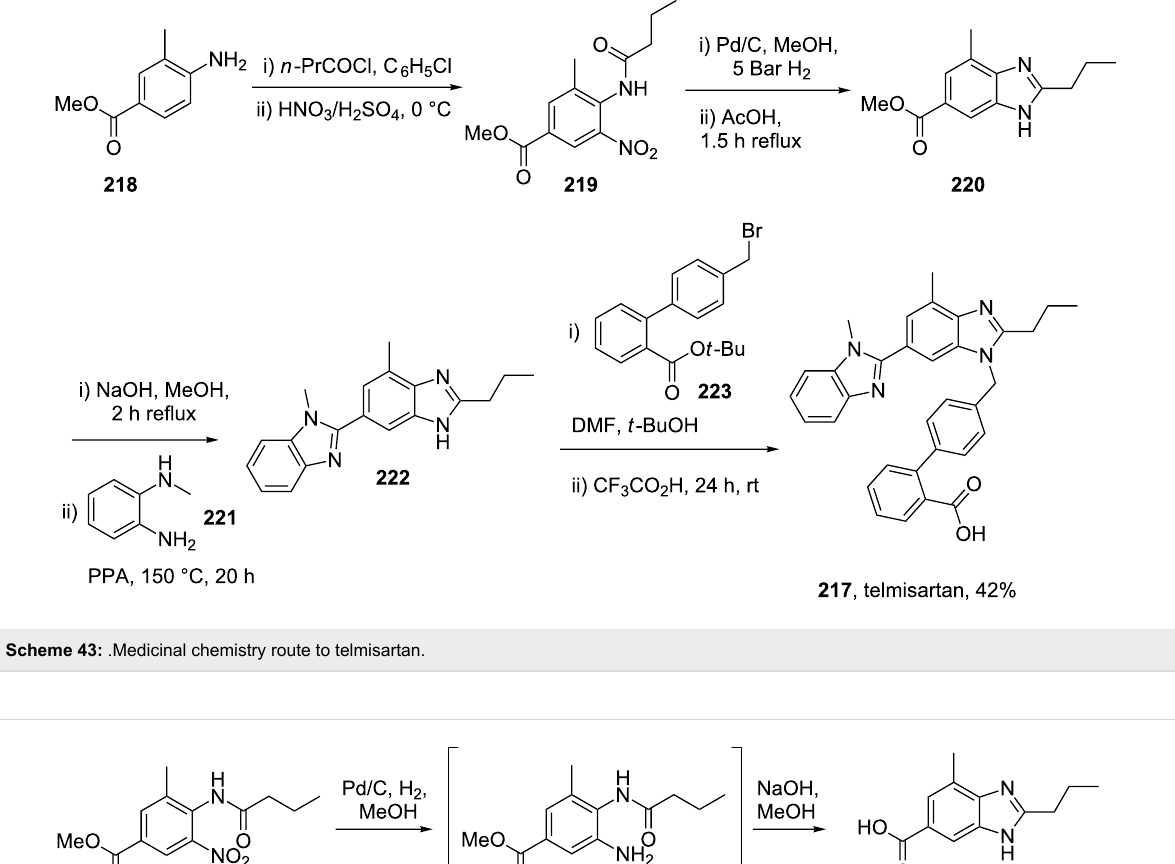
Scheme 43: .Medicinal chemistry route to telmisartan.